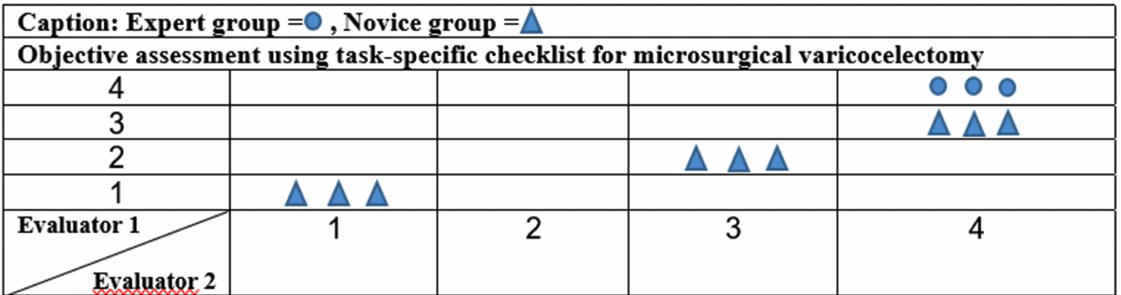
Figure 3 - Concordance of the scores between the Educational Experts and construct